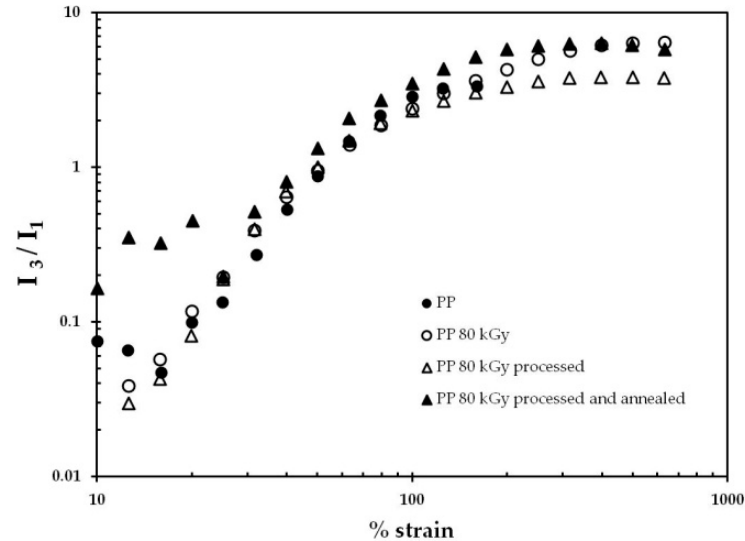
Figure 9. LAOS results (see text) for PP, irradiated PP, irradiated PP processed and irradiated PP processed and annealed during 8 h at T = 160 °C in vacuum.